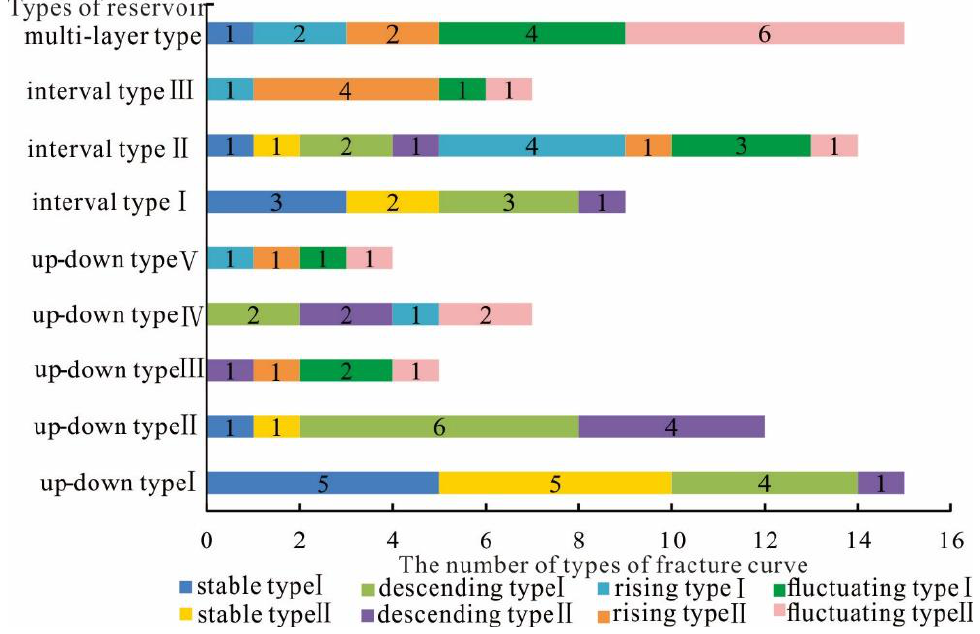
Figure 10. Fracturing curve types of reservoir types with different coal structure combinations.